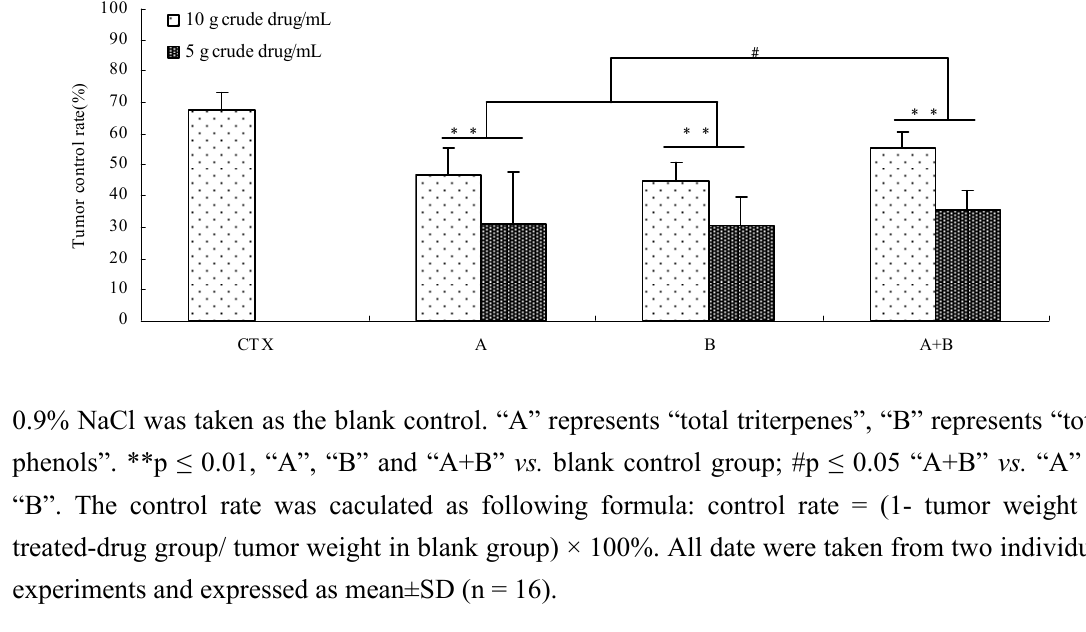
Figure 9. Effect of components and components combination on tumor control ratio of tumor-bearing mice.